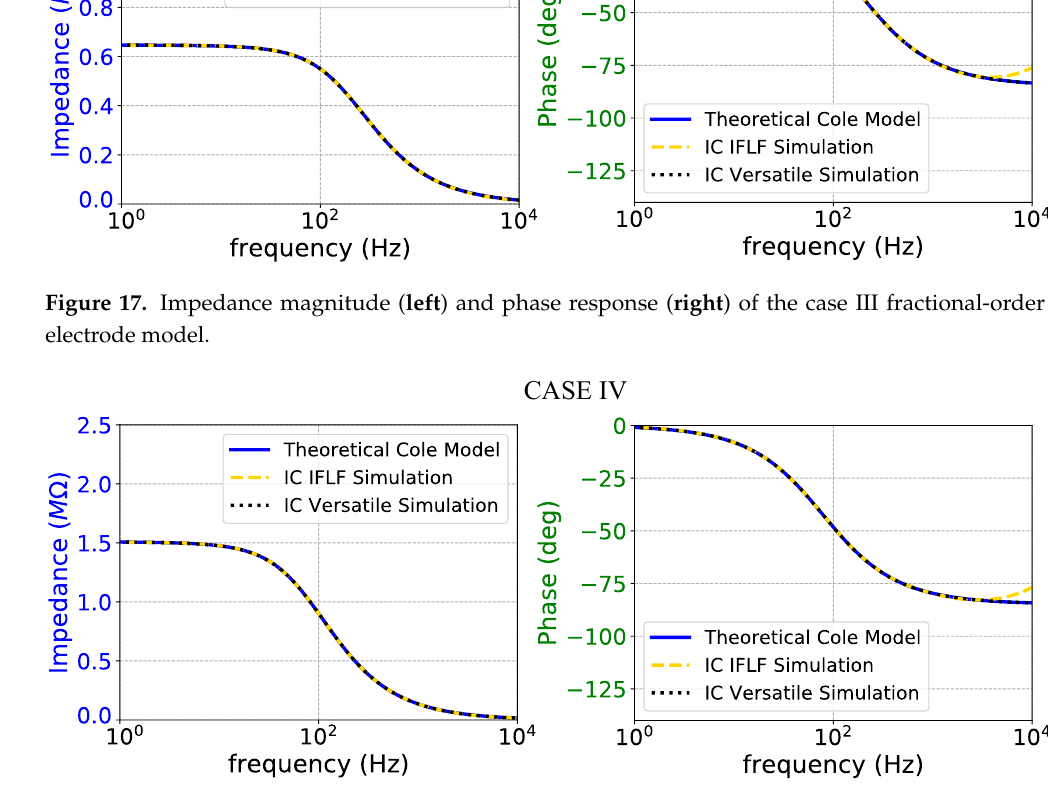
Figure 18. Impedance magnitude ( left ) and phase response ( right ) of the case IV fractional-order electrode model.